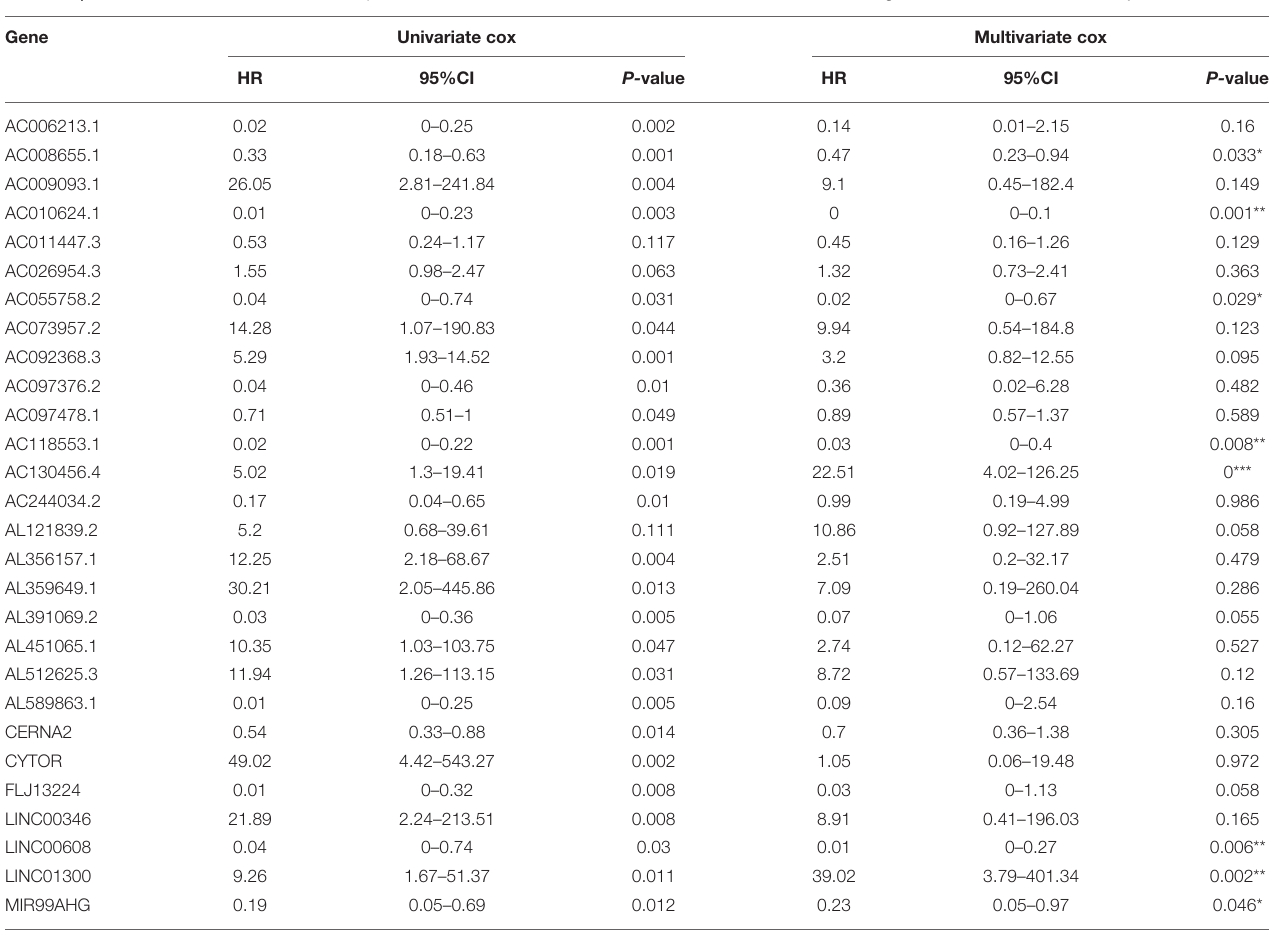
TABLE 2 | The correlations of the lncRNAs with patients’ overall survival in HNSCC based on GSE65858 dataset using uni- and multi-variate Cox